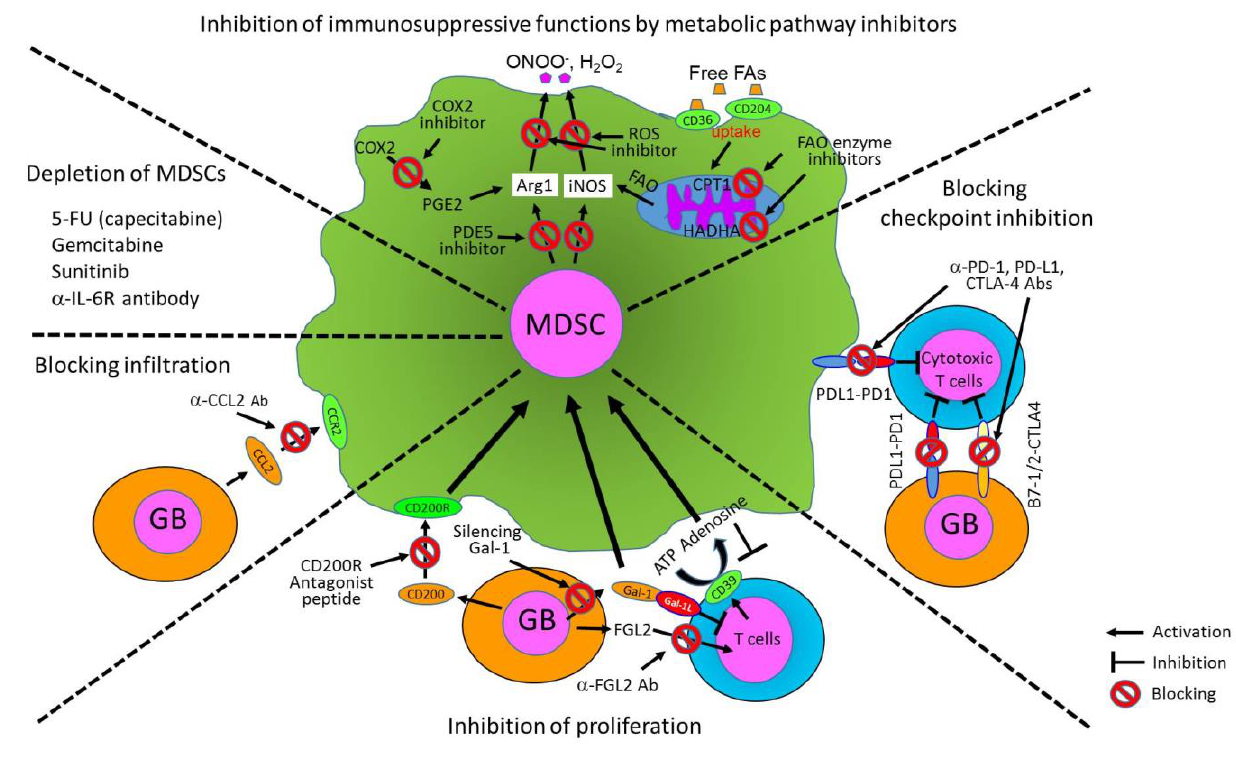
FIGURE 1: Immunosuppressive functions of MDSCs in the tumor microenvironment. The cartoon shows cellular interactions of MDSCs with tumors and immune cells and key cellular factors produced by MDSCs and tumors that promote an immunosuppressive environment both systemically and within the tumor. MDSCs can suppress anti-tumor functions of immune cells, but promote other immunosuppressive cells such as Treg and TAM as well as tumor growth and metastasis. The key cellular factors include cytokines, chemokines, surface receptors, en- zymes, and